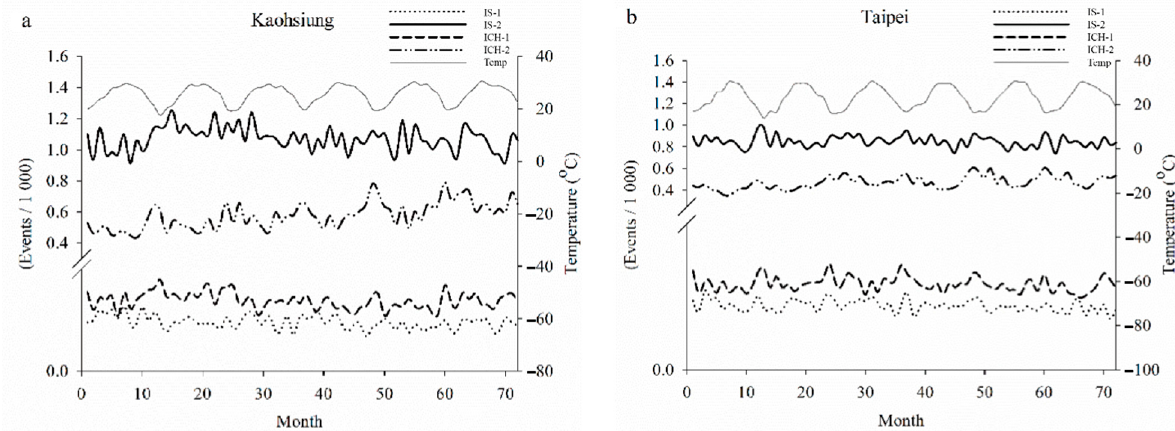
Figure 2. ( a ) Monthly events of ischemic stroke in the middle-aged group (IS-1, black dotted line) and the elderly group (IS-2, black line); intracerebral hemorrhage in the middle-aged group (ICH-1, black dashed line) and the elderly group (ICH-2, black dashed and dotted line) and the temperature (gray line) in Kaohsiung City. ( b ) Monthly events of ischemic stroke in the middle-aged group (IS-1, black dotted line) and the elderly (IS-2, black line); intracerebral hemorrhage events in the middle-aged group (ICH-1, black dashed line) and the elderly group (ICH-2, black dashed and dotted line) and temperature (gray line) in Taipei Area.